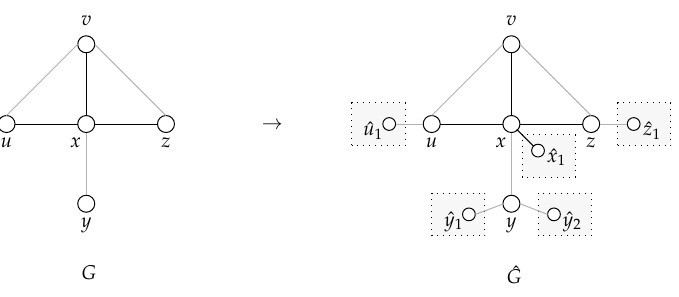
Figure 2. An example of the construction of the ( c + , c − ) -degree controller graph ˆ G associated to the signed graph G when c + = 1 and c − = 2: in this case, µ u = µ x = µ z = 1, µ v = 0 and µ y = 2. The dummy cliques (of 11 nodes each) are depicted as dotted light grey rectangles and only the degree-controller nodes in them are explicitly drawn. Negative edges are grey, and positive edges are